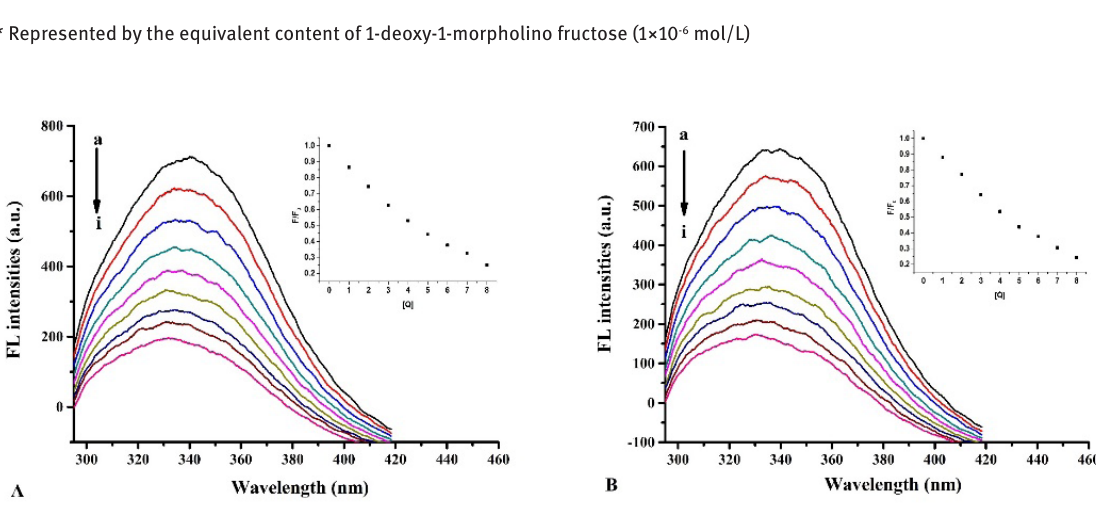
Figure 3: The quenching effect of apigenin on fluorescence spectra of HSA (A) and glycated HSA (B). λex =280 nm; HSA, 1.00 × 10 -5 mol/L; a-i: 0.00, 1.00, 2.00 .... 8.00 (× 10 -6 mol/L) of apigenin. Inset: The Stern-Volmer plots for HSA (A) and glycated HSA (B) fluorescence quenching by